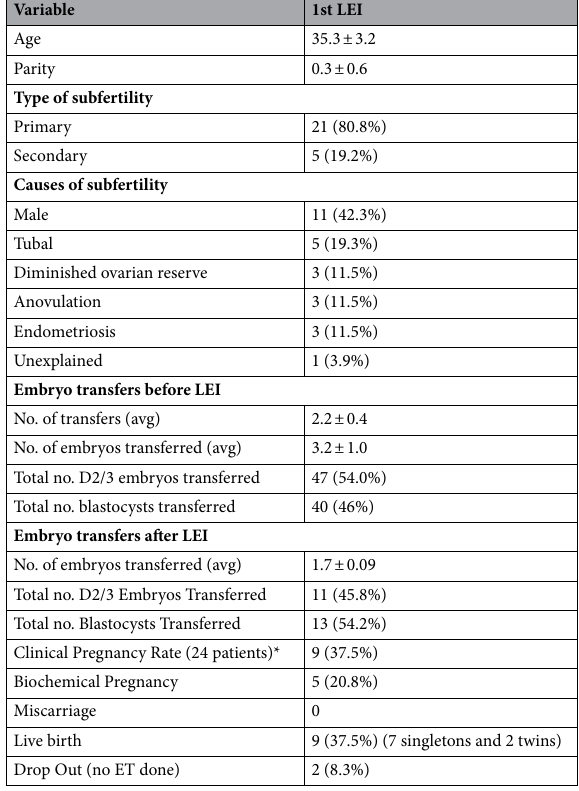
Table 1. Characteristics of 26 Patients undergoing sequential LEI. Data are mean + /− SD of n = 26 except were indicated*.